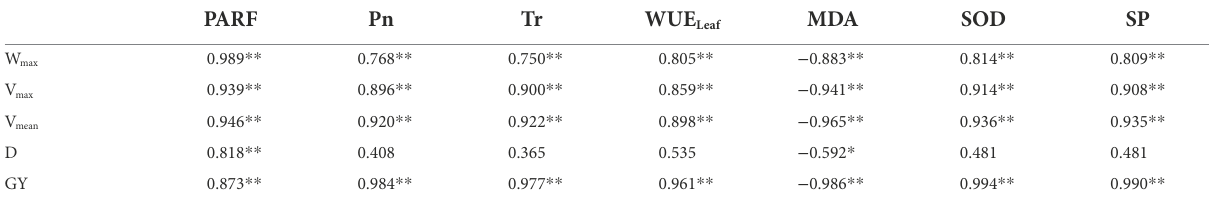
TABLE 6 Analysis of correlations among intercepted photosynthetically active radiation fraction (PARF), photosynthesis and senescence characteristics of flag leaves after anthesis, grain filling characteristic parameters, grain yield (GY) in 2017/18 and 2018/19 (n = 12).